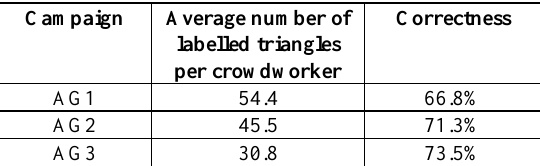
Table 4 . Results of labelling with gamification in study A.